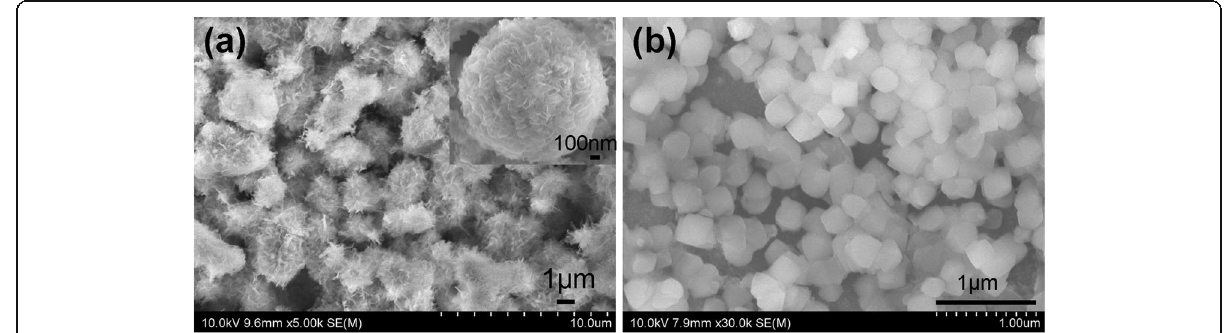
Fig. 3 Top view of a the ZnO nanoflowers and b the ZnO nanocubes. The inset of Fig. 3a is the zoom-in view of a single ZnO